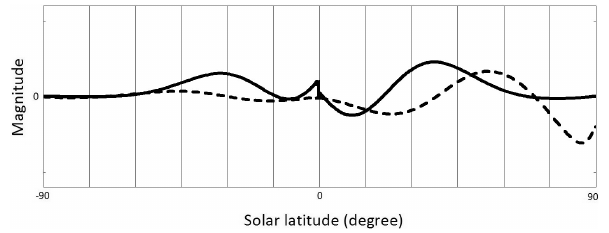
Fig. 5. Simulations for the two components of the poloidal magnetic field reproducing the latitudinal SBMF distribution for cycle 22. The solid line is obtained with D 1 = − 400, V =0.2 (region of neg- ative latitude), and V =0.1 (region of positive latitude), the dashed line – with D 2 = − 1000, v = − 0.1 (region of negative latitude), and v = − 0.5 (region of positive